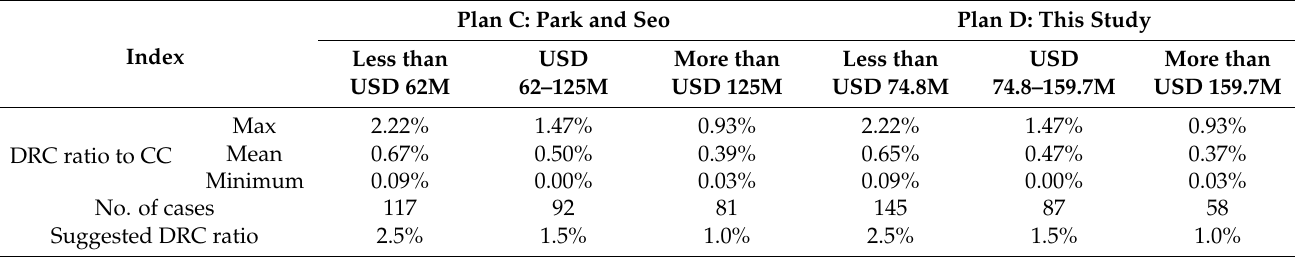
Figure 2. Decision tree of defect repair cost ratio to construction cost. Table 3. Statistics of Plan C and Plan